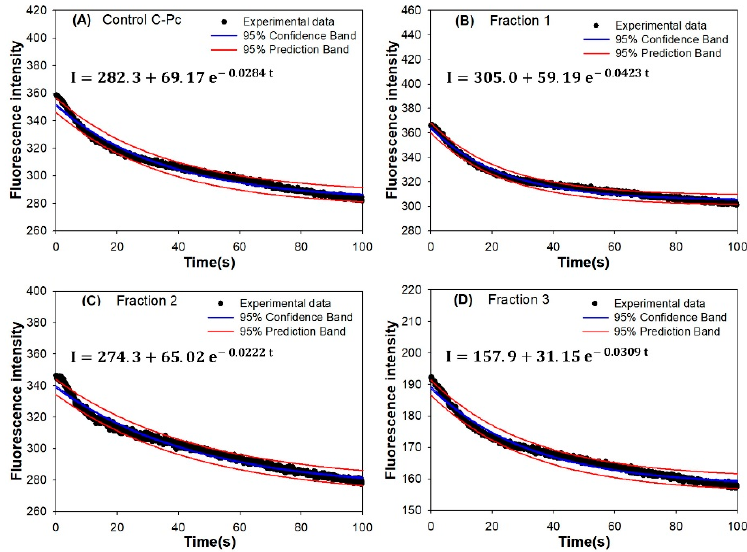
Figure 7. Mathematical modeling of fluorescence decay of phycobiliproteins.